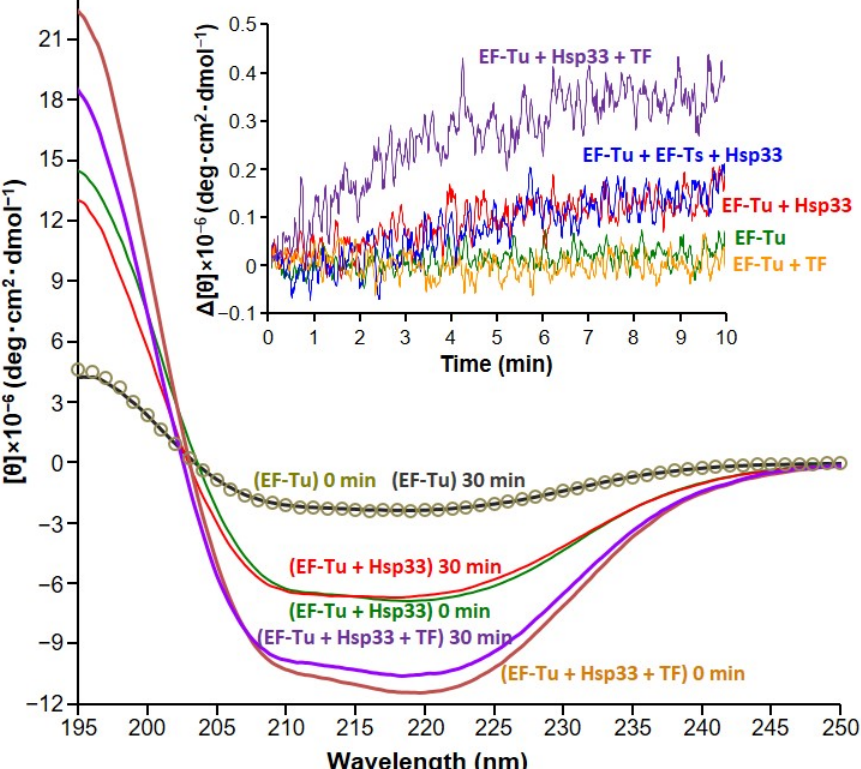
Figure 3. Conformational change of EF ‐ Tu detected via CD spectroscopy. Far ‐ UV CD spectra (main panel) were measured for the protein samples indicated in parentheses before and after 30 ‐ min incubation at 35 ° C. The CD intensities measured for diluted samples (10, 5, and 3 μ M for EF ‐ Tu, EF ‐ Tu:Hsp33, and EF ‐ Tu:Hsp33:TF, respectively) before and after the incubation, which was performed with 0.2 mM of each protein, were normalized as molar ellipticity ([ θ ]). The inset shows time ‐ dependent change of molar ellipticity ( Δ [ θ ]) at 222 nm, for the indicated protein samples (15 μ M) during incubation at 35 ° C in the CD cell.